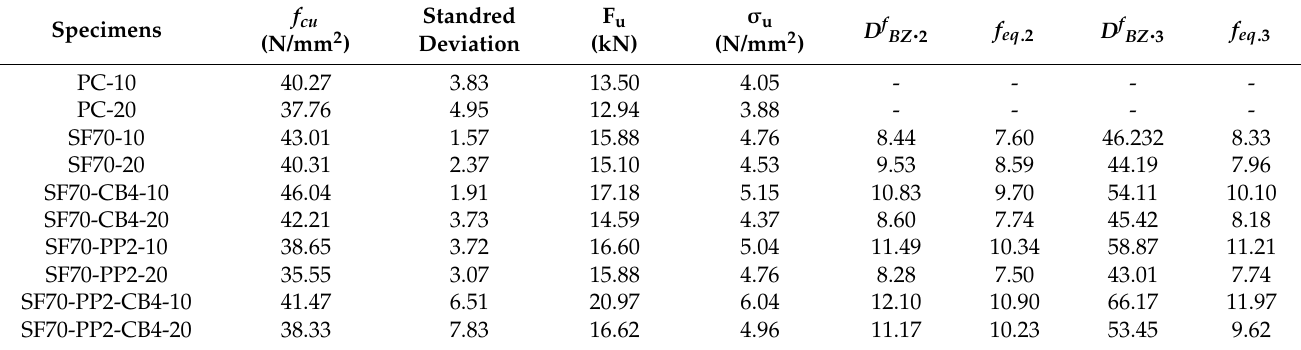
Figure 3. Flexural load-deflection curves of 5–10 mm coarse aggregates and 15–20 mm coarse aggregates. Table 3. Compression strength, flexural strength and toughness